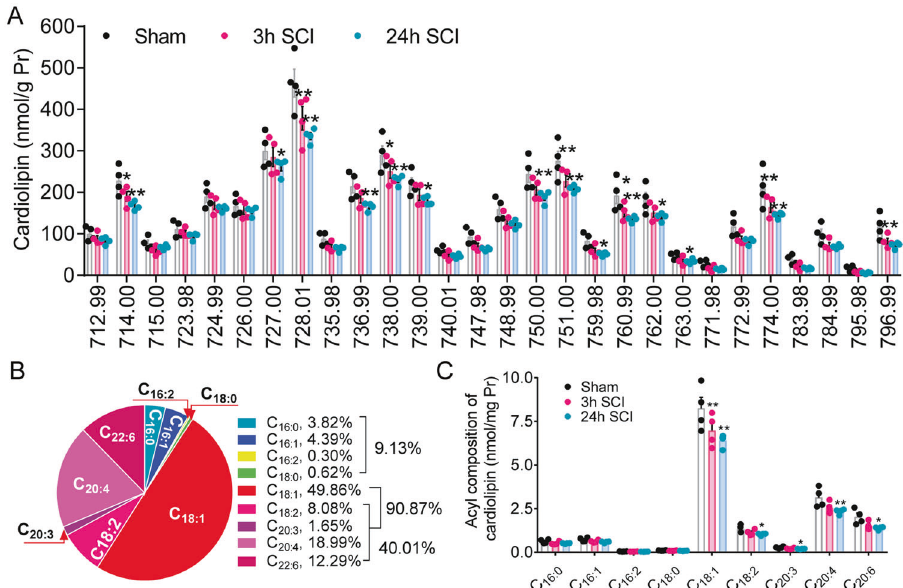
Fig. 2 Quanti fi cation of molecular species and acyl composition of cardiolipin (CL) in the injured spinal cord at 3 and 24 h after SCI. A Quanti fi cation of CL molecular species at 3 and 24 h after SCI. Over 50 distinct CL molecular species were readily identi fi ed. Of them, 50% of species of CL were signi fi cantly reduced after SCI. * P < 0.05, ** P < 0.01 vs. sham (Two-way ANOVA, Tukey ’ s multiple comparisons test, n = 4 rats/groups). Data represent mean ± s.e.m. The x -axis is mass-to-charge ratio (m/z). B , C Quanti fi cation of acyl composition in CL species at 3 and 24 h after SCI. 18:1 fatty acid was predominantly composed of CL and was 49.86% of CL compositions. The following enrichment of acyl was 20:4 (AA, 18.99%), 22:6 (DHA, 12.29%) and 18:2 (LA, 8.08%). After SCI, all decreased CL acyls were unsaturated fatty acids; of them, 50% were poly-unsaturated fatty acids. * P < 0.05, ** P < 0.01 vs. sham (Two-way ANOVA, Tukey ’ s multiple comparisons test, n = 4 rats/groups). Data represent mean ±